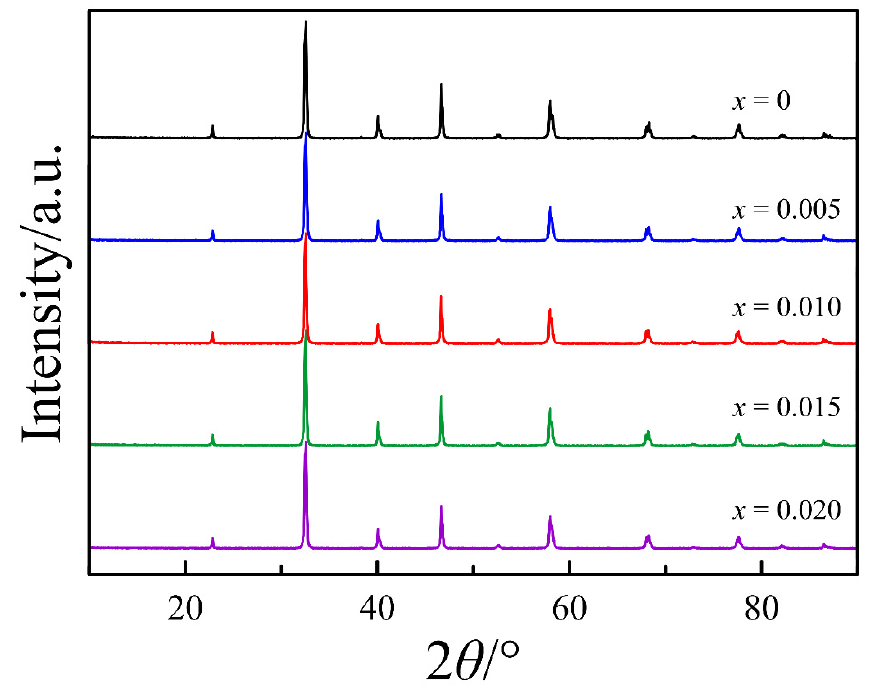
Figure 1. Room temperature X-ray powder diffraction patterns of La 0.5 − x Sr 0.5 FeO 3 − δ . Table 1. Structural parameters of La 0.5 − x Sr 0.5 FeO 3 − δ refined in Rhombohedral setting of